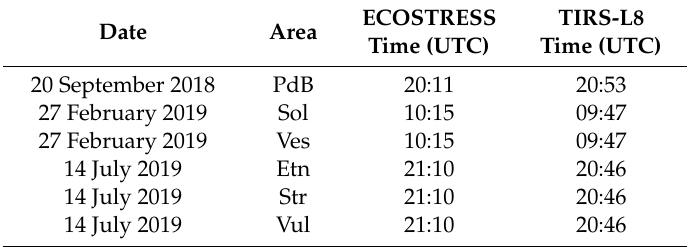
Table 2. ECOSTRESS and L8 data for the same time and close in time.